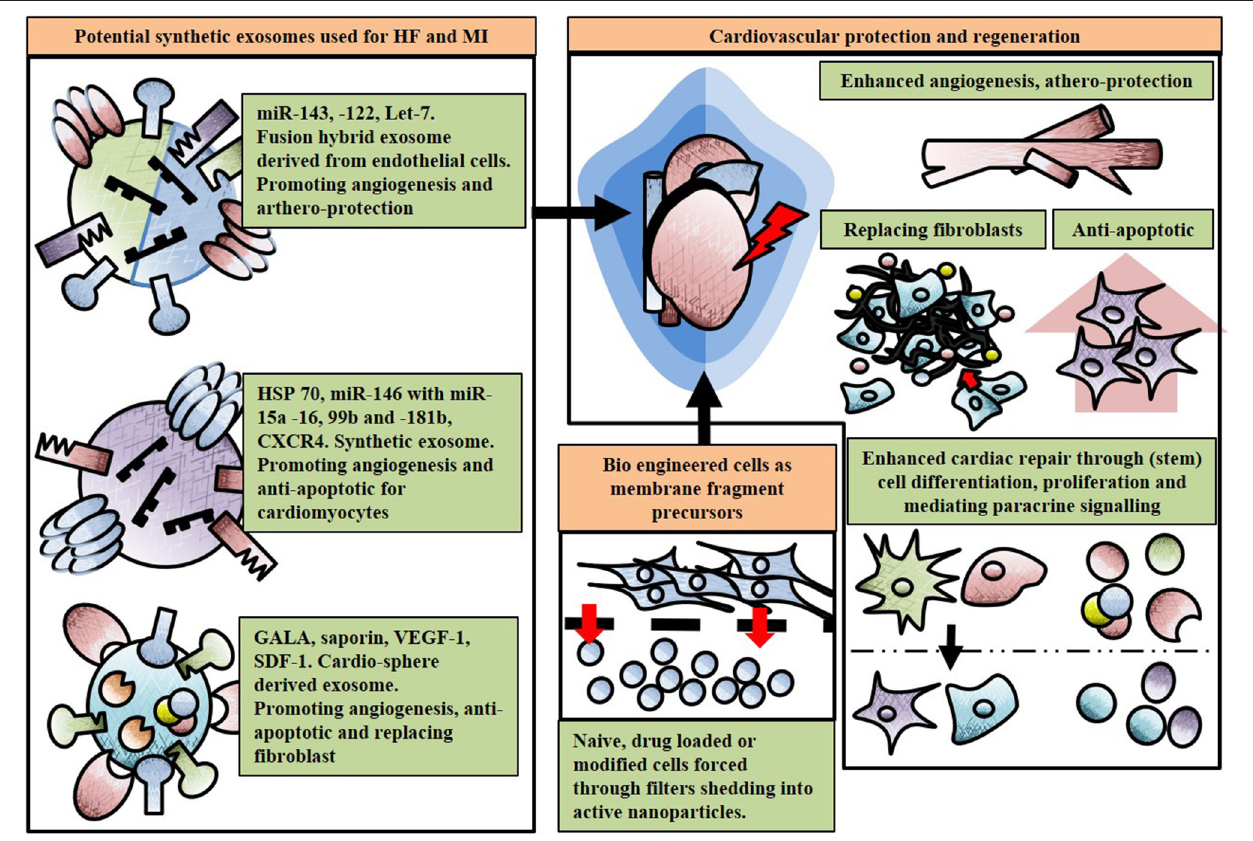
FIGURE 3 | Potential use and effect of engineered and artificial exosomes. Exosomes can be enhanced through hybrid fusion, lipid conjugation or fragment precursors with various cargo and surface compositions for cardio-protection post myocardial infarction (MI) or cardiac regeneration in heart failure (HF). All non-cell geometries represent exosomes, growth factors such as vascular endothelial growth factor (VEGF), receptors, heat shock proteins (HSP) or microRNAs (miRs).